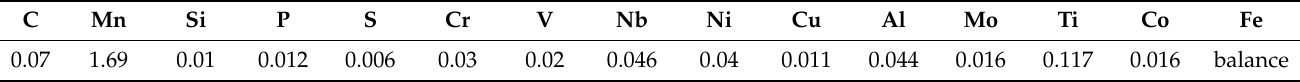
Table 1. Chemical composition of base material (wt %).